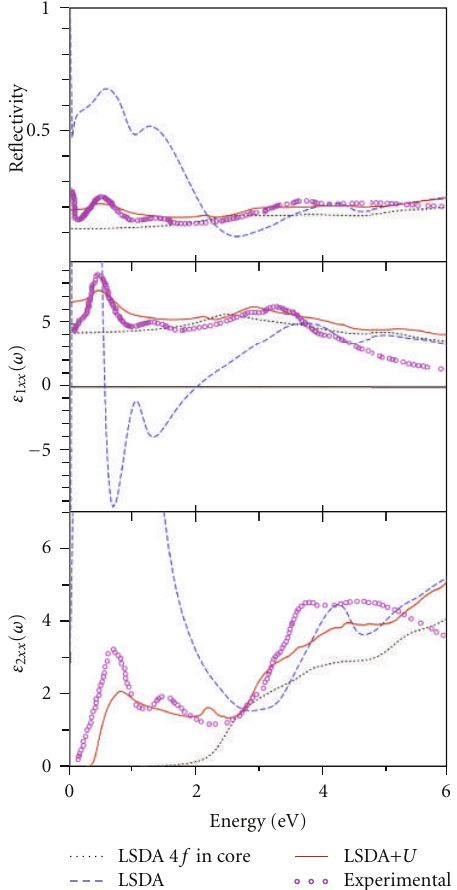
Figure 50: Calculated optical reflectivity R , real and imaginary parts of the diagonal dielectric function, ε 1 xx , ε 2 xx of SmS [313] treating 4 f states as (1) fully localized (4 f in core) (dotted line), (2) itinerant (dashed line), and (3) partly localized (LSDA+ U ap- proximation) (solid line) compared with experimental data (open circles)